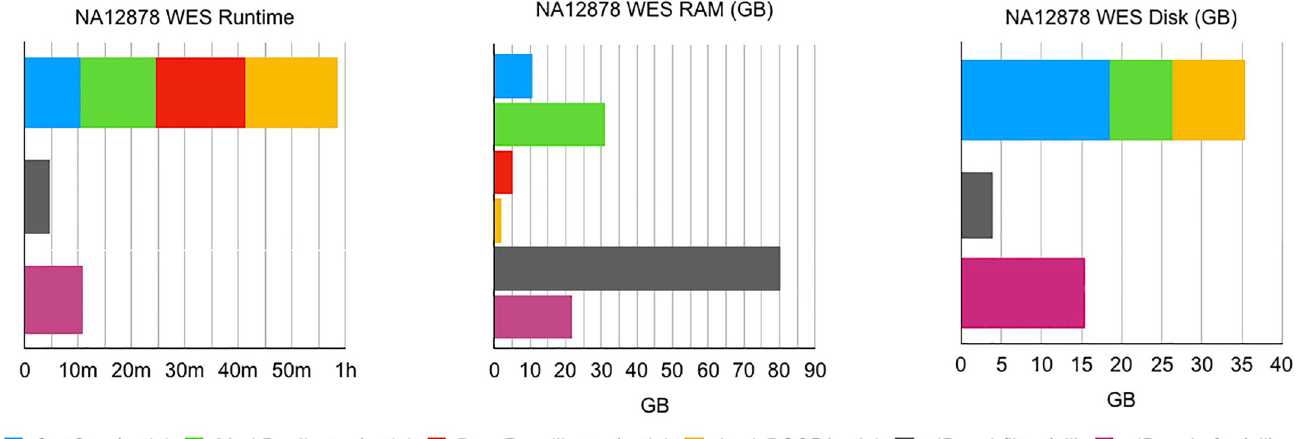
Fig 1. WES benchmarks. Runtime, RAM use, and disk use in GATK 4 vs. elPrep 4 (filter mode) vs. elPrep 4 (sfm mode). We see 5.4-13x speedup for 0.7-2.6x RAM use and 0.6-0.2x disk use when comparing elPrep 4 filter/sfm to GATK 4. The results, i.e. final BAM, metrics and recalibration files, are the same for all